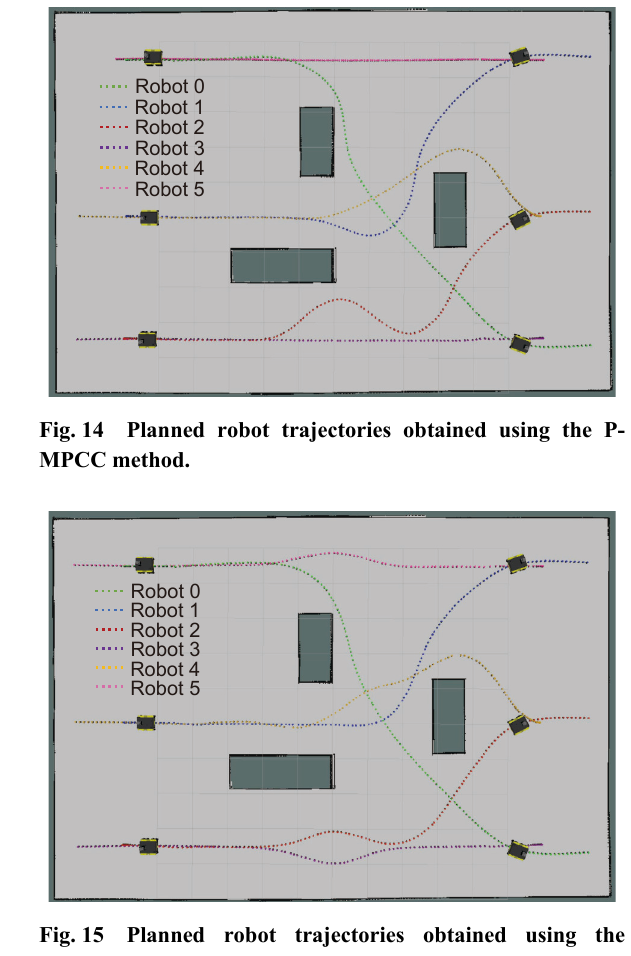
Figure 15 records the trajectories of the six robots determined by the proposed D-MPCC method. It can be seen that all the robots show cooperative behavior